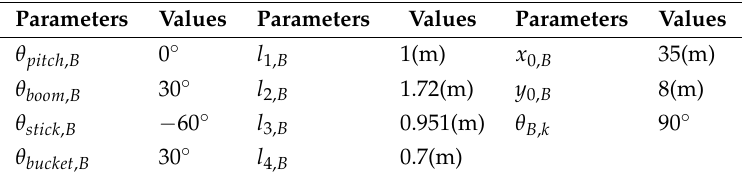
Table 2. Posture Parameters of Simulation: B.